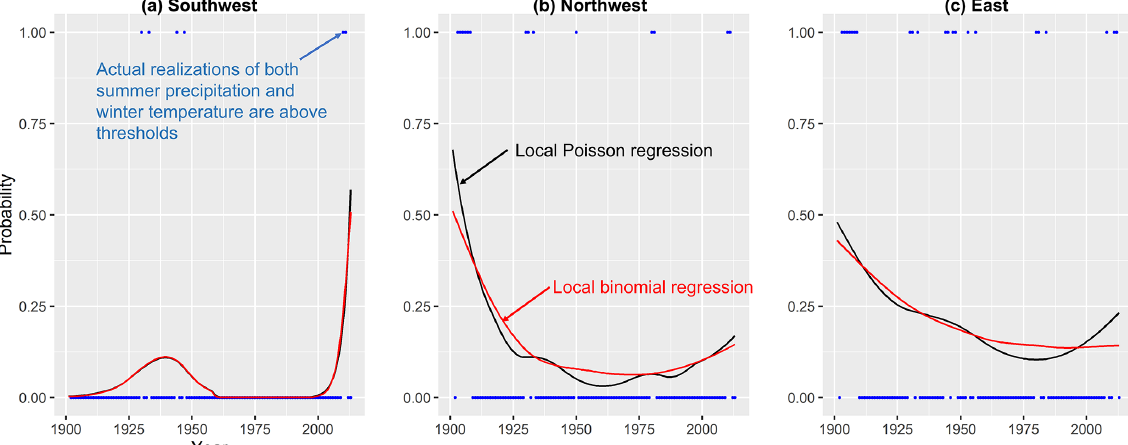
Figure 13. Binary index for the co-occurrence of threshold exceedance of PDSI values and winter temperature. The local regression is based on the optimal bandwidth of a local quadratic regression function based on the generalized cross-validation criteria considering that the binary indicator is an outcome of a nonhomogeneous Poisson process. Note the tendency for a cluster in the beginning for the northwest and the east. The increase in the frequency for the trend function in the most recent period could represent more of an edge effect of the